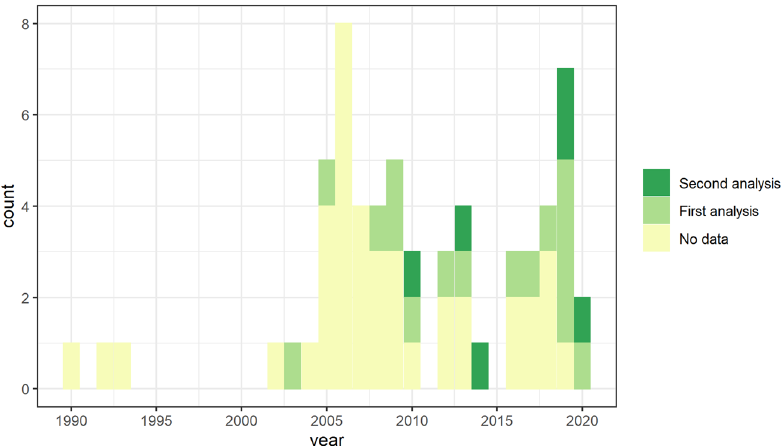
Fig. 2 Studies breakdown by year and data usage. Colours indicate whether a study used data or not, and if so, whether it used data on a speci fi c population for the fi rst time (First analysis) or for a second time or more (Second analysis). Populations are de fi ned according to the languages they speak and the region or country they inhabit.